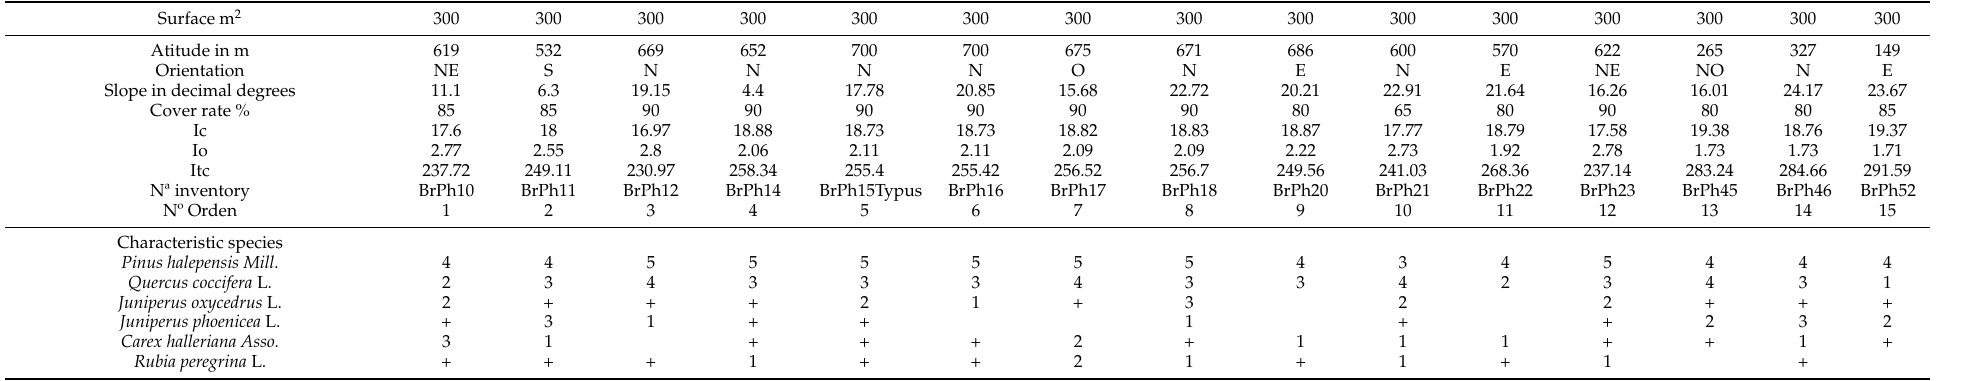
Table A2. Bupleuro rigidi-Pinetum